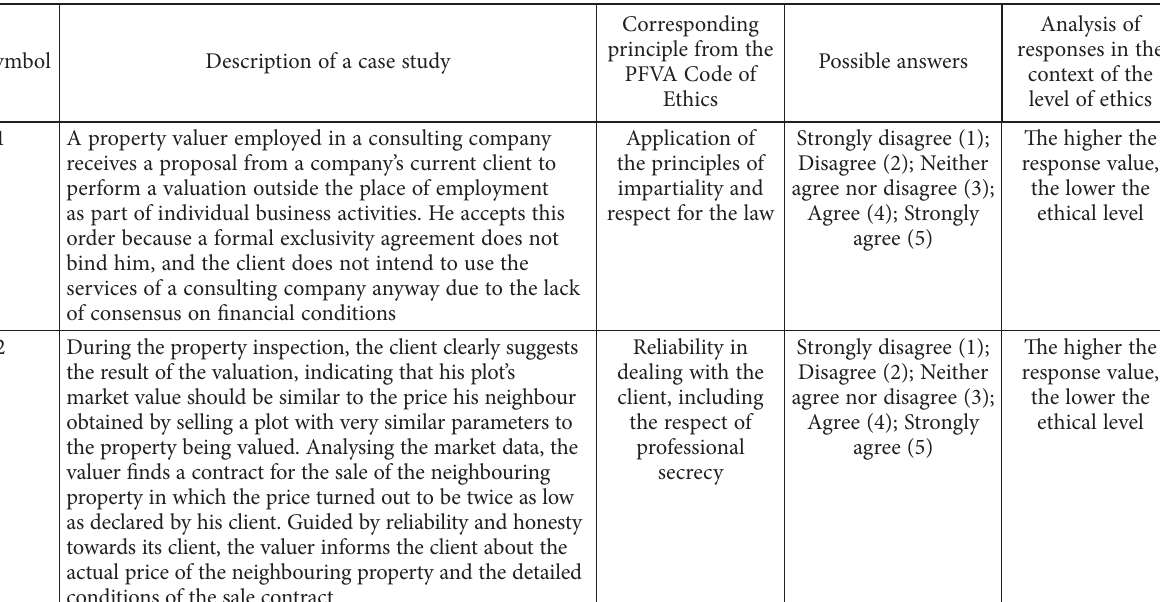
Table A1. Designed case studies to analyse the level of ethical attitude among valuers